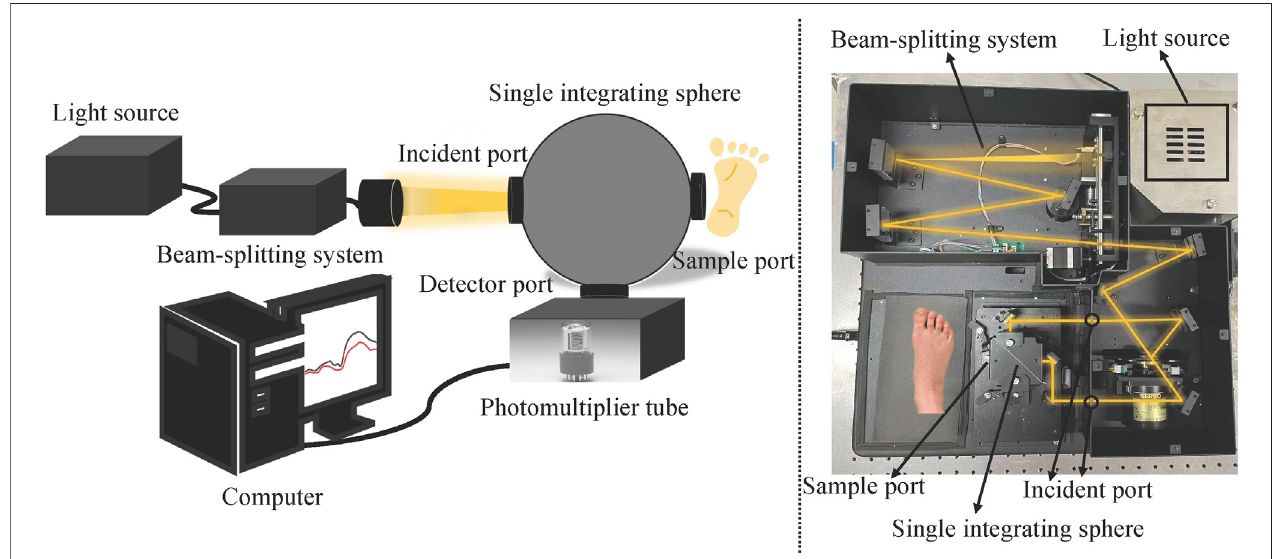
FIGURE2| Schemeoftheintegratedsingleintegratingspheresystem(Left);Physicaldiagramofthesingleintegratingspheresystem(Right).Thelightemittedfrom thehalogenlightissplitthroughamonochromatorinthebeam-splittingsystemtoemitlightofaspeci fi cwavelength,focusesontheincidentportandreachesthesample port. Subsequently, the light re fl ected by the sample tissue through a series of re fl ections and refractions in the integrating sphere, which is fi nally received by the photomultiplier tube at the detection port.